Question: Draft a figure caption describing what is shown.
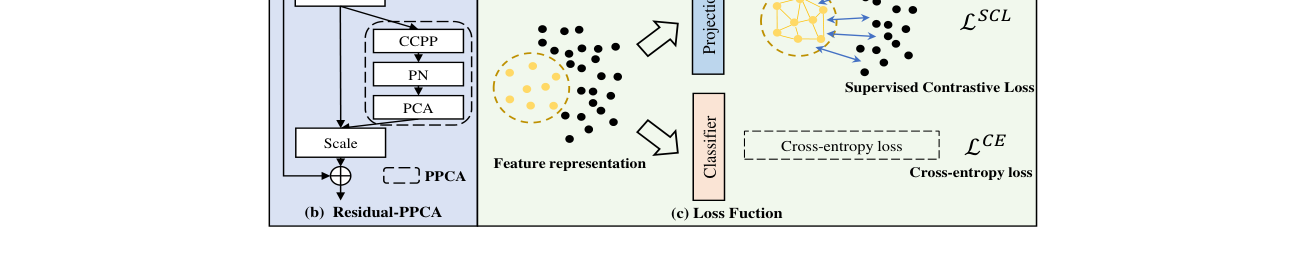
Answer: Pyramid pixel context adaption network (PPCANet) for medical image classification (a), in which we combine the PPCA module with the residual module to construct a Residual-PPCA module (b). Furthermore, to achieve better performance, we adopt supervised contrastive loss as the supplement for cross-entropy loss for further exploiting label information (c).